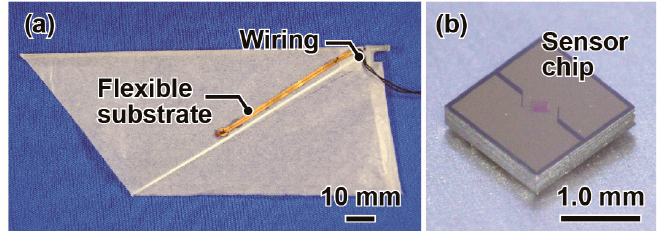
Figure 2. Photographs of ( a ) the hindwing with substrate and ( b ) the sensor